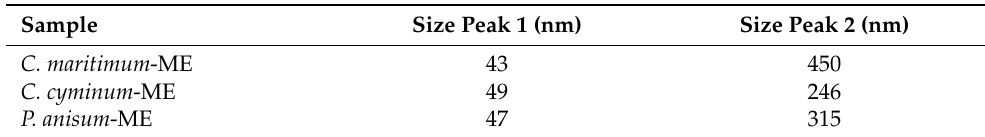
Table 2. Z-average sizes (nm) of the two populations present in each formulation measured with the DLS technique.